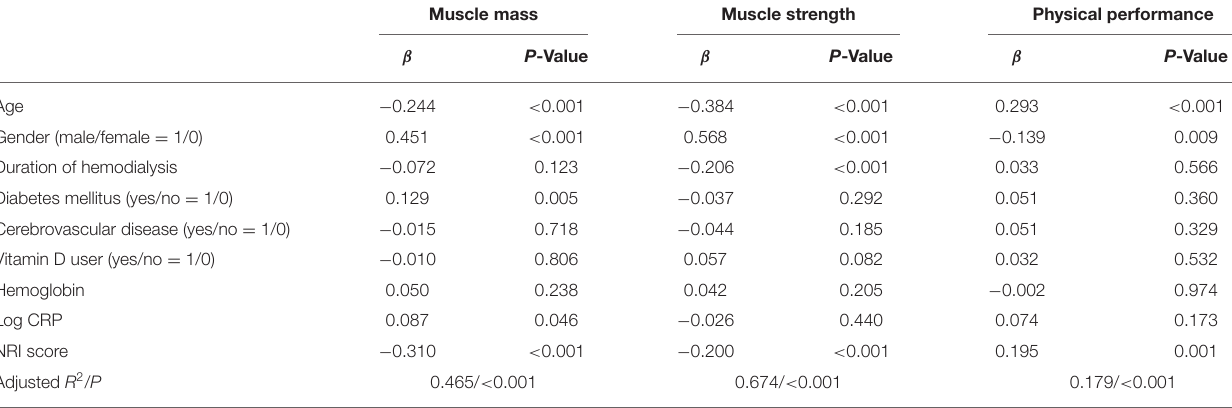
TABLE 3 | Multivariable linear regression analysis of factors possibly associated with muscle mass, muscle strength, and physical performance. Muscle mass Muscle strength Physical performance β P -Value β P -Value β P -Value Age − 0.244 < 0.001 − 0.384 < 0.001 0.293 < 0.001 Gender (male/female = 1/0) 0.451 < 0.001 0.568 < 0.001 − 0.139 0.009 Duration of hemodialysis − 0.072 0.123 − 0.206 < 0.001 0.033 0.566 Diabetes mellitus (yes/no = 1/0) 0.129 0.005 − 0.037 0.292 0.051 0.360 Cerebrovascular disease (yes/no = 1/0) − 0.015 0.718 − 0.044 0.185 0.051 0.329 Vitamin D user (yes/no = 1/0) − 0.010 0.806 0.057 Hemoglobin 0.050 0.238 0.042 0.173 NRI score − 0.310 < 0.001 − 0.200 < 0.001 0.195 0.001 Adjusted R 2 / P 0.465/ < 0.001 0.674/ < 0.001 0.179/ < 0.001